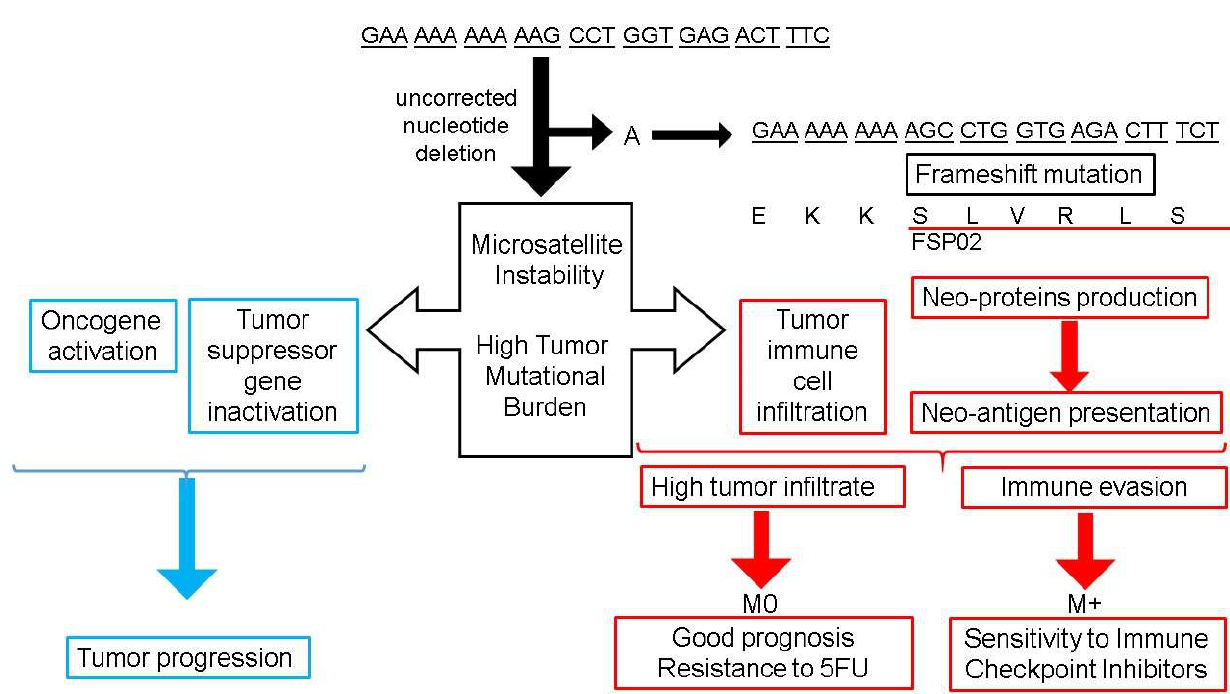
Figure 2. Mismatch Repair deficiency: Consequences on tumor biology and outcome in colorectal cancer. The upper right part of the figure shows an example of frameshift mutation in the tumor growth factor β receptor II ( TGFβ-RII ) gene. The single nucleotide deletion of an adenosine (A) is not corrected by a deficient mismatch repair, leading to a frameshift mutation and a modified sequence of amino-acids corresponding to the frameshift peptide (FSP02). The left part of the figure summarizes the consequence of frameshift mutation on tumor progression. The lower part of the figure summarizes consequences of such uncorrected mutations on immune tumor environment and their clinical impact. M0: Non metastatic colorectal cancer; M+: Metastatic colorectal cancer.